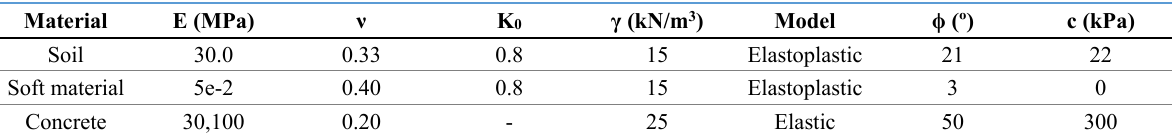
Table 1. Mechanical characteristics and materials deformability.